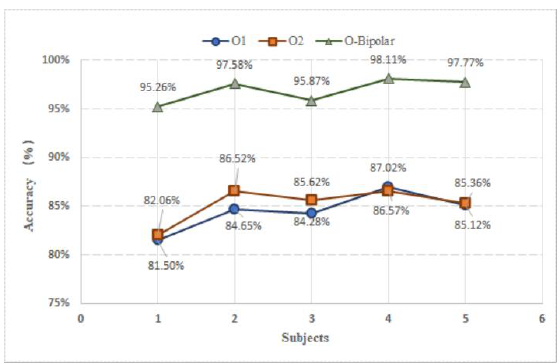
Figure 5. Performance comparison between different channels.